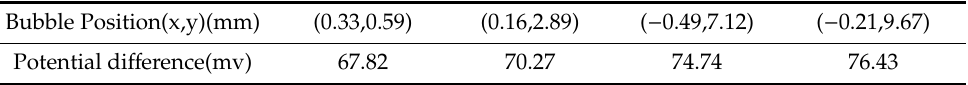
Table 3. The induced potential di ff erence when the bubble is on the y-axis.